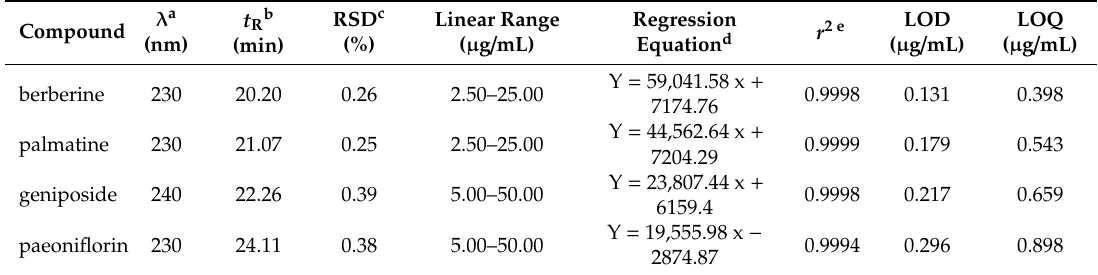
Table 1. Retention times, linear range, calibration curves, limits of detection (LODs), and limits of quantitation (LOQs) of the four compounds ( n =